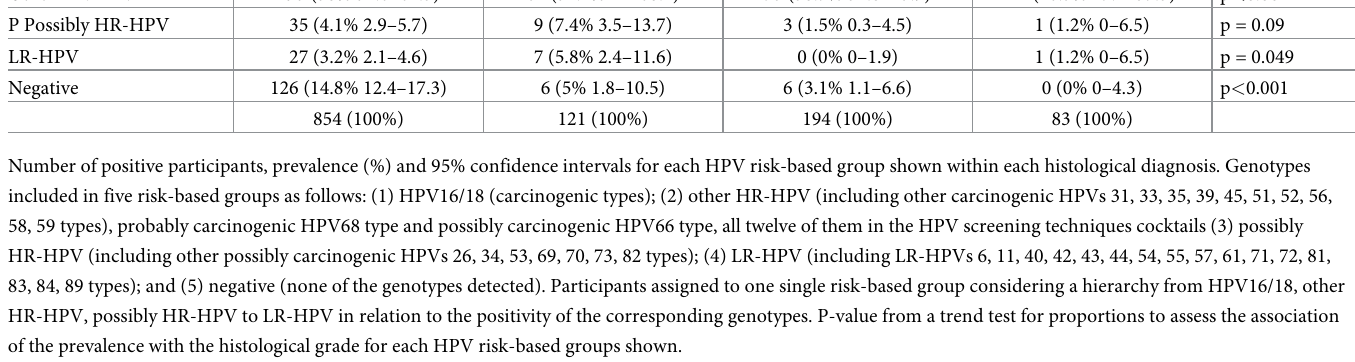
Table 2 describes the prevalence of HPV genotype risk-based groups within histological diagnoses among HPV screened positive women. A significant increasing trend of the HPV16/18 group prevalence with histological grade was observed (ranging from 20% in � CIN1, to 30.6% in CIN2, 56.7 in CIN3 and 71.1% in CC, p-value for trend < 0.001); con- versely, the prevalence of other HR-HPV groups decreased with histological grade (ranging from 58%, to 51.2%, 38.7 and 26.5%, respectively, p-value for trend < 0.001). The prevalence of other possibly HR-HPV and LR-HPV genotypes was much lower, and mostly found in women with � CIN1 and CIN2 diagnoses (4.1% and 7.4%, respectively for possibly HR-HPV and 3.2% and 5.8%, respectively for LR-HPV). The majority of women with no HPV genotype detected were among those with a � CIN1 diagnosis. No substantial differences were observed in the prevalence of HPV genotype risk-based groups when distinguishing between colpos- copy/biopsy negative and CIN1 diagnoses (S1 Table). Despite a higher genotypic diversity in women with � CIN1 and CIN2 diagnoses compared to CIN3 and CC cases (Fig 2), HPV16 was the most prevalent genotype in all histological groups, prominently in women with cancer, observing a significant upward trend with histo- logical grade (ranging from 14.5%, 19.8%, 51.5% to 65.1% in � CIN1, CIN2, CIN3 and cancer, respectively, p-value for trend p < 0.001) (Table 3). Furthermore, among women with CC, the prevalence of the remaining HPV genotypes was below 9%; among women with CIN3, HPV31 was the second most prevalent genotype, followed by HPV52, HPV58 and HPV33 (12.9%,